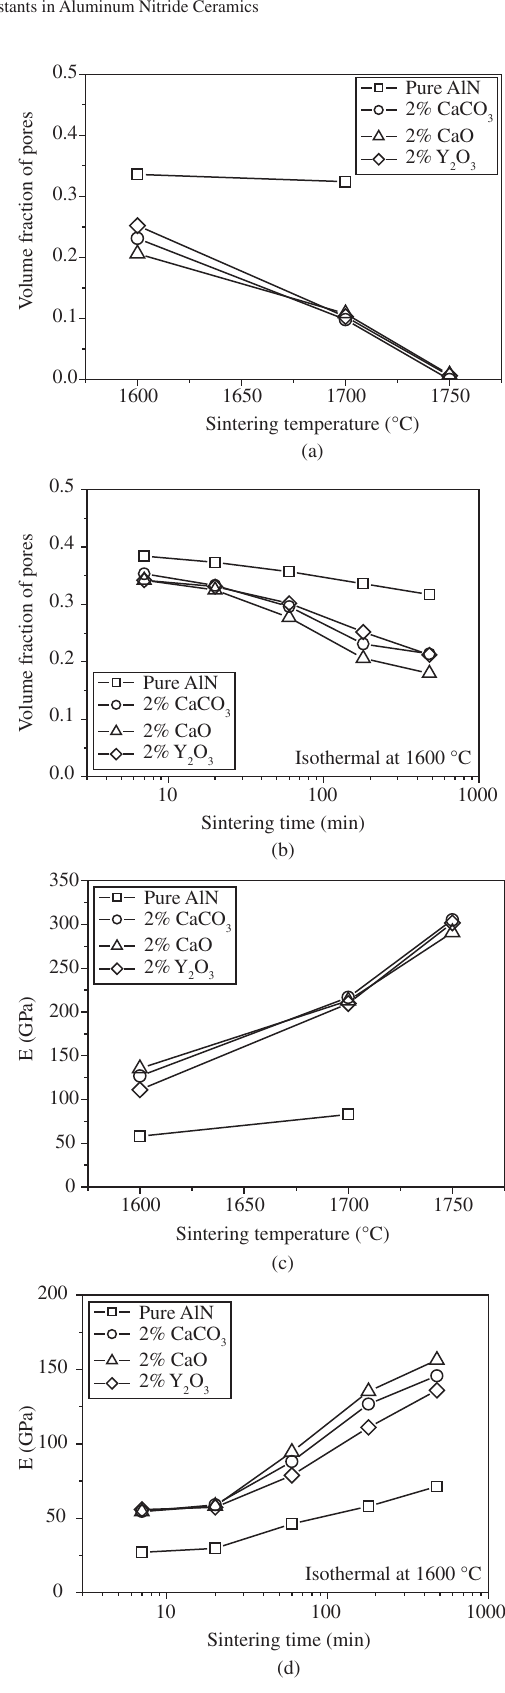
Figure 2. Porosity as a function of a) sintering temperature (3 hours) and b) sintering time (1600 °C), and Young’s modulus as a function of c) sintering temperature (3 hours) and d) sintering time (1600